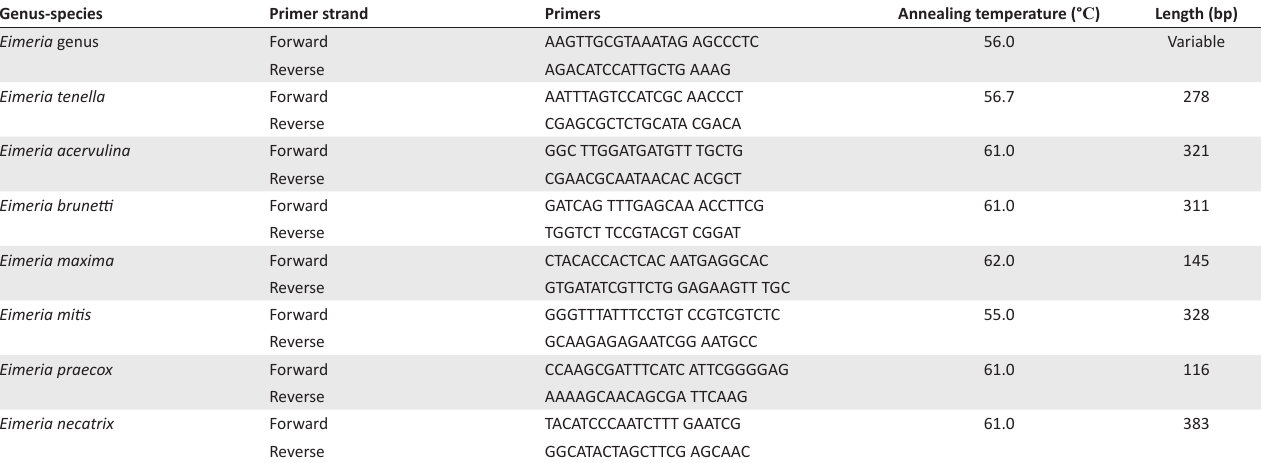
TABLE 1: Genus- and species-specific internal transcribed spacer-1 primers used in the study.